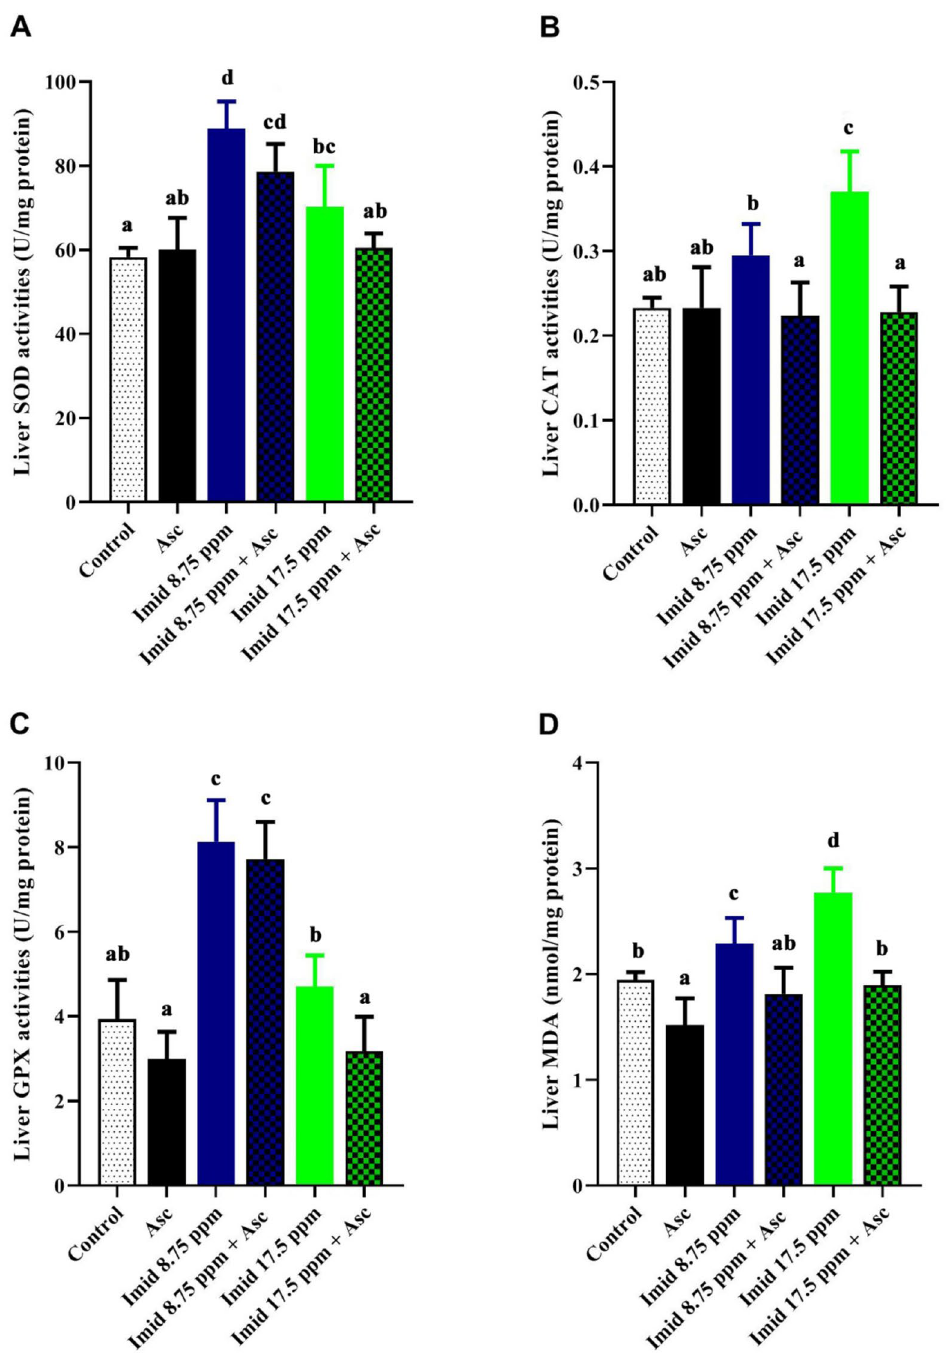
Figure 2. The ameliorative effect of ascorbic acid (Asc) on imidacloprid (Imid)-induced oxidative stress on the liver of O. niloticus when administrated for 21 days. ( A ) Superoxide dismutase (SOD); ( B ) Catalase (CAT); ( C ), Glutathione peroxidase (GPX) and ( D ) Lipid peroxides (LPO). Imid was added at concentrations of 8.75 and 17.5 ppm and Asc was applied at 50 ppm. Values were expressed as mean ± standard deviation (SD), bars refer to SD, (n = 5 fish). Different letters above the columns indicate significant differences at p < 0.05 between